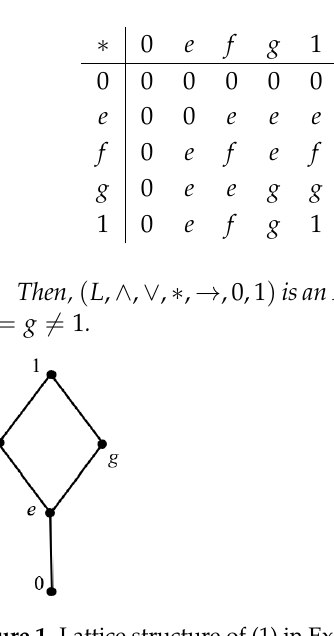
Figure 1. Lattice structure of (1) in Example 3.